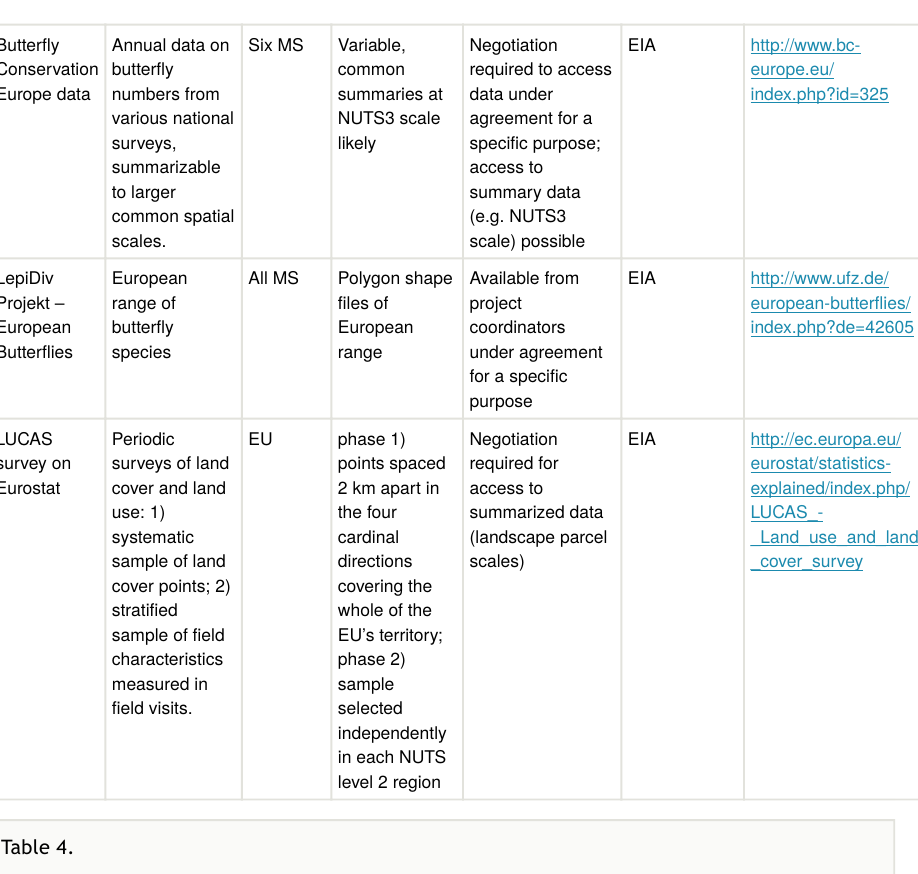
Marine biodiversity data sets and related environmental data sets at the EU level. (see Suppl. material 1 for further information and links to